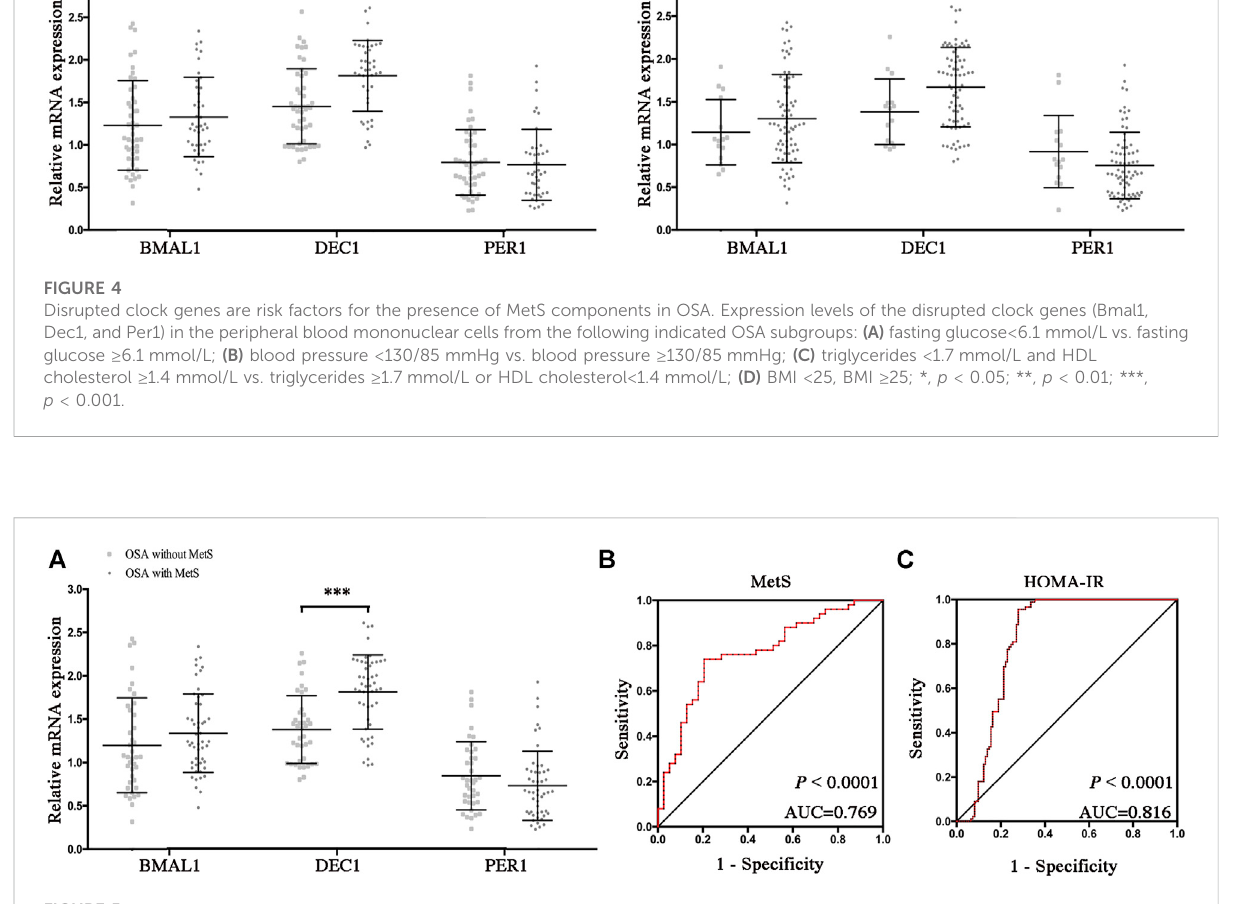
FIGURE 5 Increased DEC1 anticipates MetS and insulin resistance in OSA. (A) Expression levels of the disrupted clock genes (Bmal1, Dec1, and Per1) in the peripheral blood mononuclear cells between OSA-non-MetS and OSA-MetS subgroups (OSA-non-MetS vs. OSA-MetS). (B – C) ROC curve analyses were performed to evaluate the discriminatory power of Dec1 for MetS (B) and HOMA-IR (C) . ***, p <